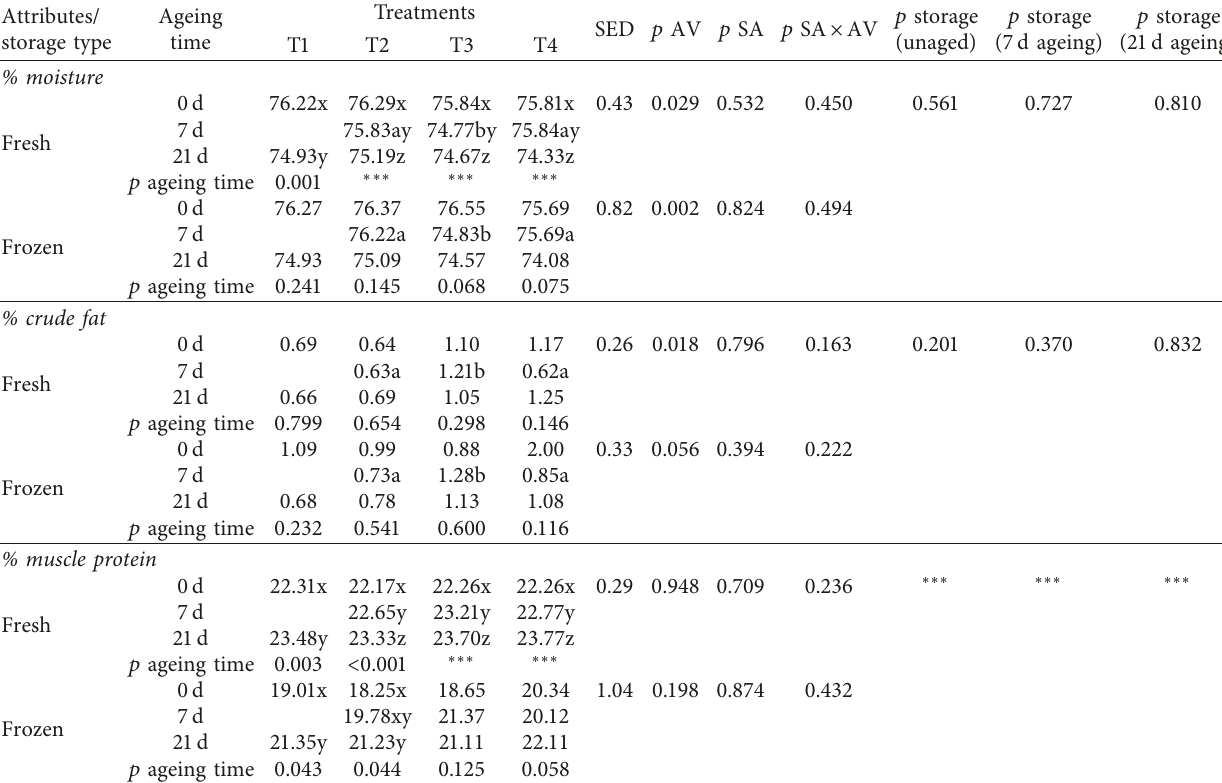
Table 1: Effect of ageing treatments, ageing time, and frozen storage on the proximate content of in-bag dry-aged lean bull beef. Attributes/ storage